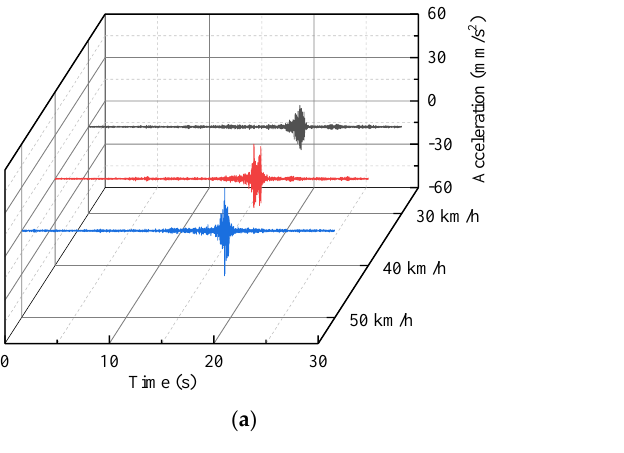
Figure 20. Predicted acceleration time − history of the third floor measuring point (D − P2) under the heavy − duty truck (horizontal east − west direction): ( a ) third floor measuring point (D − P2) acceleration time − history prediction based on the amplitude − RTR; and ( b ) third floor measuring point (D − P2) acceleration time − history prediction based on the RMS − RTR.